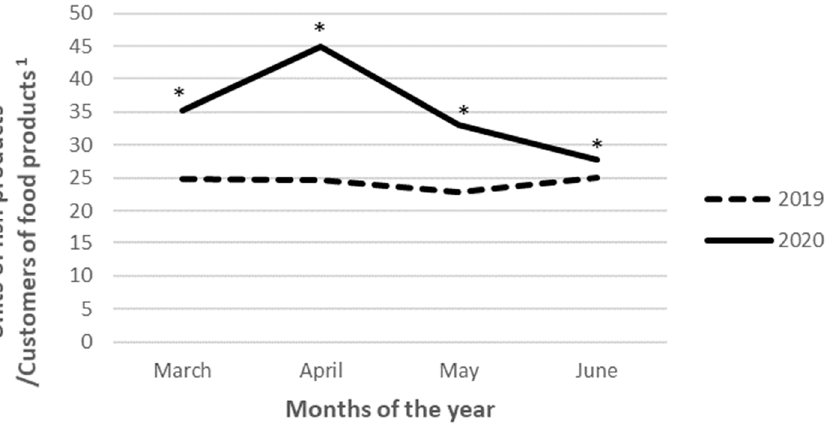
Figure 1. Total purchases of fish, seafood, and fish products by Spanish consumers during the period March to June in 2019 and 2020. * Significant differences ( p < 0.001) between 2019 and 2020. 1 Number of loyalty card holders that made at least one purchase of food products during the periods analyzed.